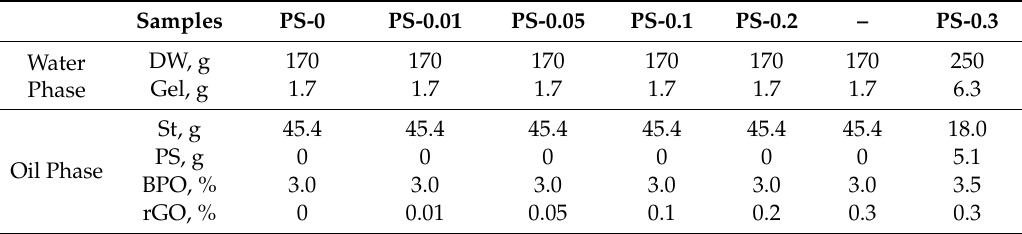
Table 1. Preparation ingredients of pure PS and PS / rGO nanocomposites beads.